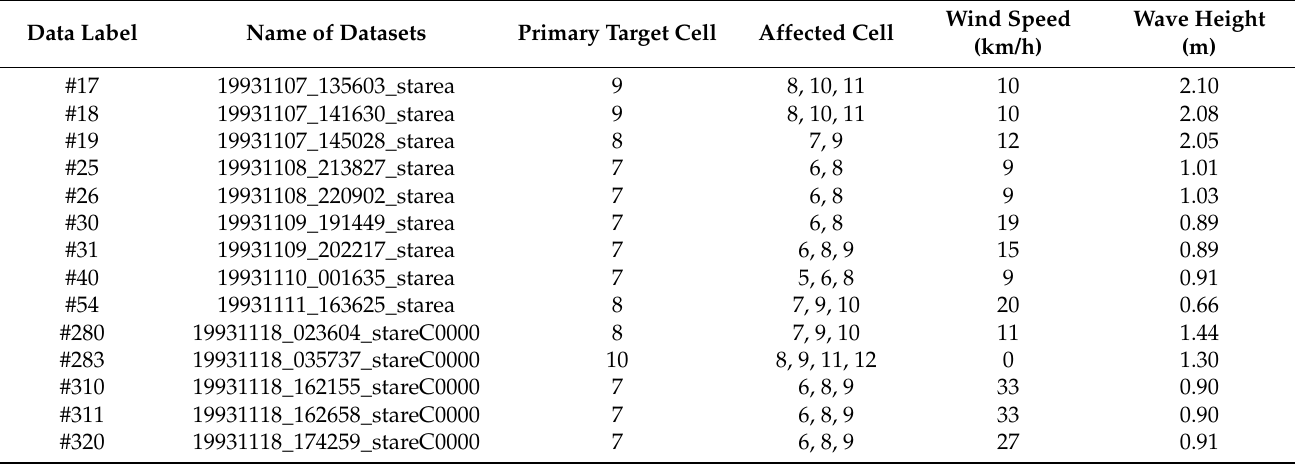
Table 1. 1993 IPIX radar data main parameter description.